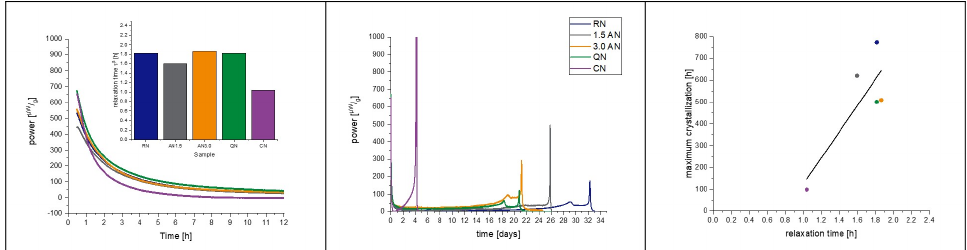
Figure 8. Samples from the 2 mgmL_1.6PS_Suc formulation at 40 °C; correlation of crystallization with α-relaxation, and the effect of the freezing step. The left picture presents a zoomed in area of the IMC measurement to focus on the relaxation curves, which are converted to a τ β -value. The middle graph shows the full view of the measurement including the crystallization of the samples. On the right, the correlation of relaxation time with crystallization maximum of the IMC curves is presented. The correlation coefficient of the fit is r 2 = 0.58. Random nucleation (blue), additional annealing step of 1.5 h (grey), additional annealing step of 3.0 h (orange), quench cooling (green), controlled nucleation (purple).